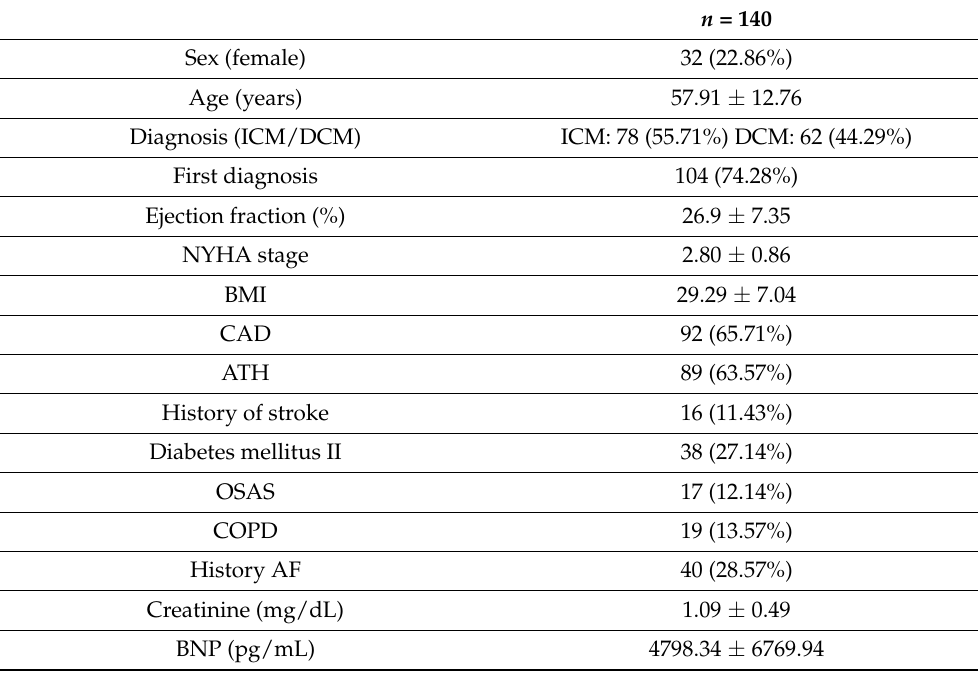
Table 1. Baseline characteristics.